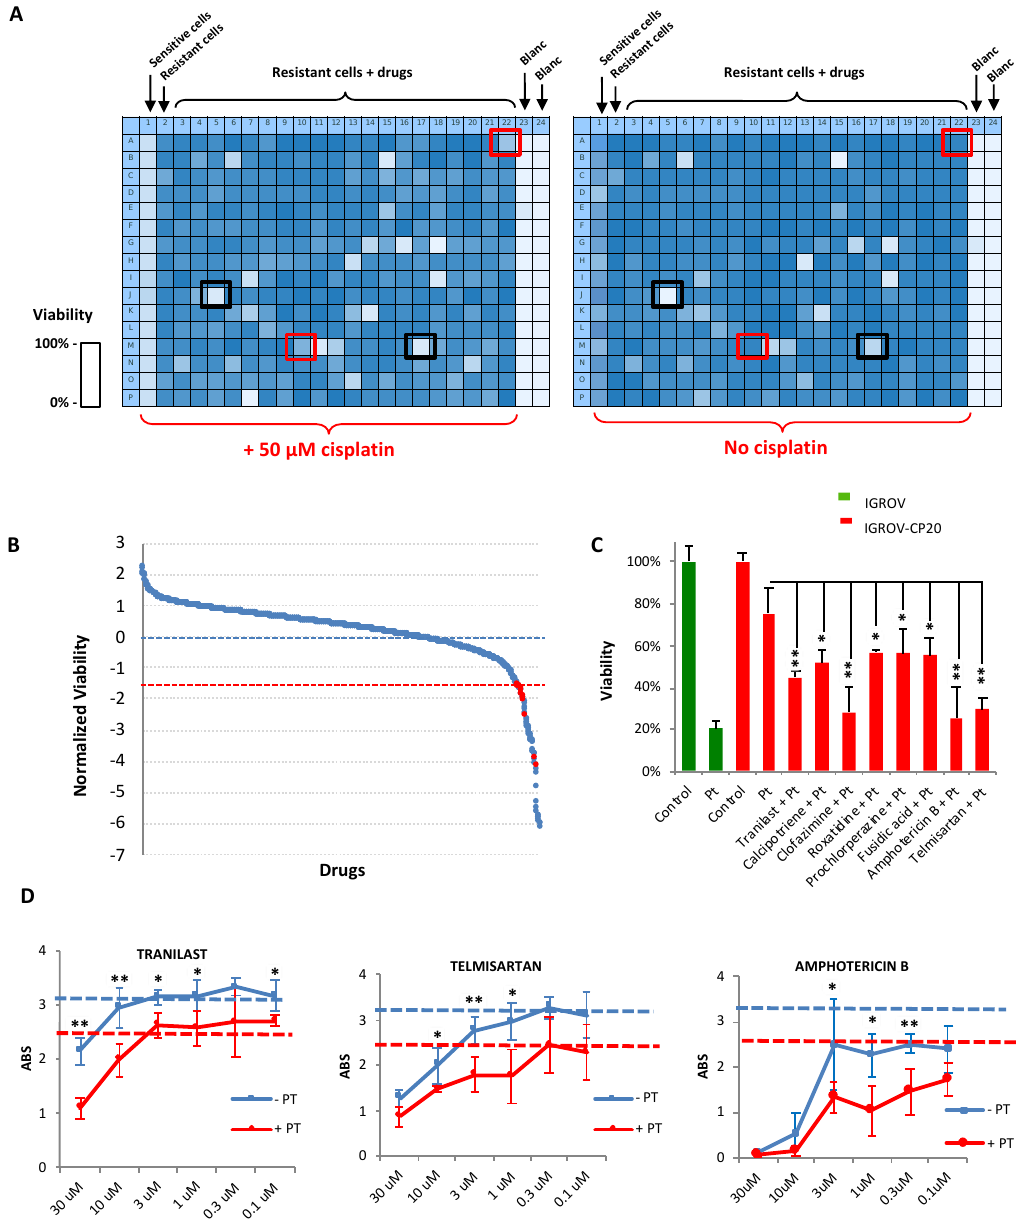
Figure 2. Synthetic lethality screening revealed FDA-approved drugs that promote platinum (Pt)-mediated death of IGROV-CP20 cells. ( A ) Heat maps showing the MTT signal (with blue indicating cell survival and white cell death) in two 384-well plates from the high-throughput screen (HTS). Sensitive IGROV cells were used as controls for cisplatin efficiency, while IGROV-CP20 cells were seeded in the central areas of each plate and treated with drugs from a library of 1280 FDA-approved molecules. For each set of drugs from the library one plate was treated with 50 µM cisplatin while the second plate with identical array of drugs was left without cisplatin. Drugs killing the cells only in combination with cisplatin were considered as the hits (red boxes), while drugs inducing cell death per se (black boxes) were excluded. ( B ) The panel shows the outcome of the screening. The average viability of IGROV-CP20 cells in cisplatin was considered as 0 (blue dash line). Standard deviation (SD) values of IGROV-CP20 cells in cisplatin were used to normalize the average MTT signal for each drug. Each drug, whose combination with cisplatin caused decrease in viability beyond an arbitrary threshold of 1.5 SDs (red dash line) was considered as a hit (red circle) if this drug did not induce toxicity without cisplatin. ( C ) The graph shows the percentage viability of IGROV-CP20 cells after treatment with the positive hits in combination with cisplatin (Pt) ( n = 3 experiments; * p < 0.05, ** p < 0.01, ANOVA). ( D ) Quantification of MTT absorbance (as readout of viability) shows dose-response